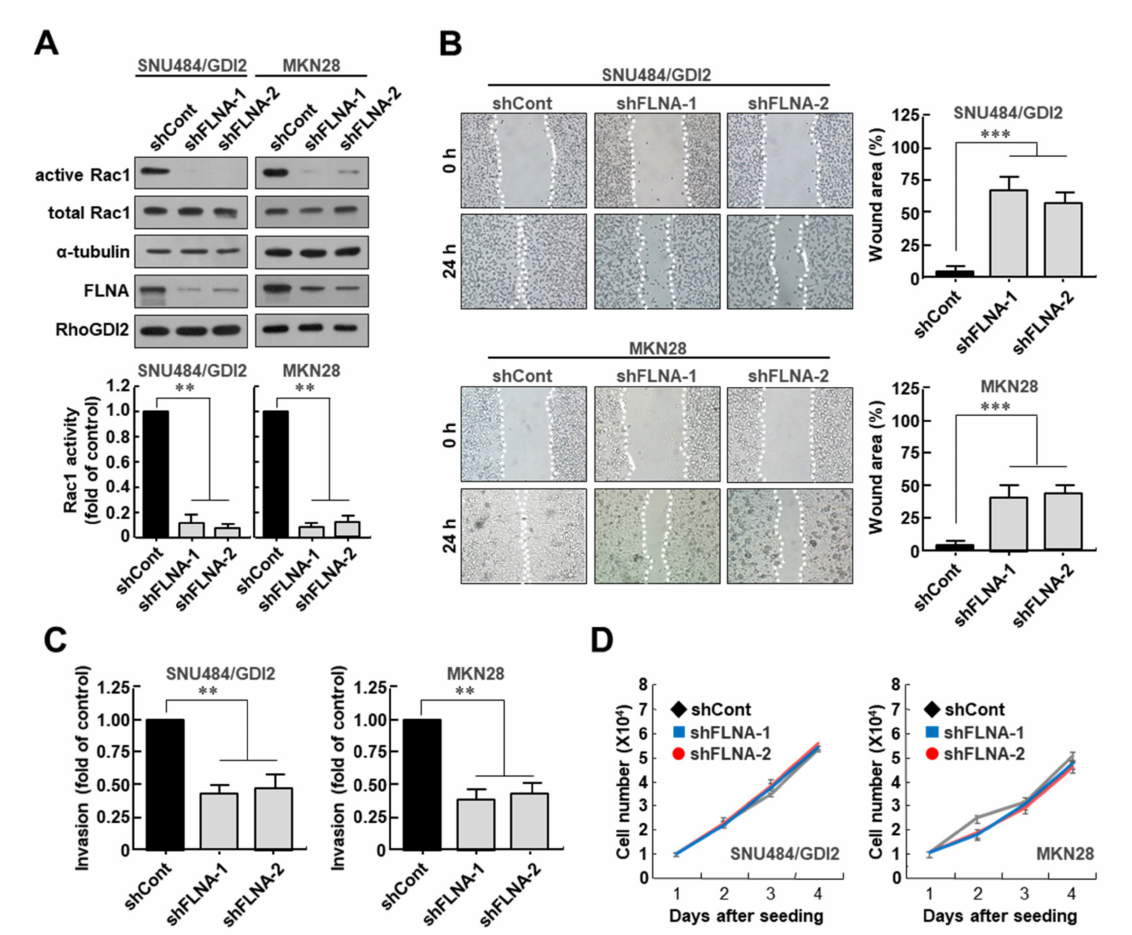
Figure 3. Filamin A is required for Rac1 activation and invasive ability of gastric cancer cells. ( A ) Effect of Filamin A depletion on Rac1 activity in RhoGDI2-overexpressing SNU484 and MKN28 gastric cancer cell lines. Filamin A-depleted cell lysates were precipitated with a PAK1-agarose and analyzed by Western blot using anti-Rac1 antibody (upper). The data are representative of three independent experiments and ImageJ software was used to calculate the relative active Rac1 levels (lower). For normalization, total Rac1 and α -tubulin expressions were used as controls. **, p < 0.01 as determined by t -test. The uncropped immunoblot images can be found in Figure S5. ( B ) Effect of Filamin A depletion on migration ability of RhoGDI2-overexpressing SNU484 and MKN28 gastric cancer cells. A wound-healing assay was used to examine the migration ability of Filamin A-depleted SNU484/GDI2 and MKN28 cells, with wound closure visualized using phase-contrast microscopy ( left ). WimScratch software (Wimasis) was used to measure the wound areas. The percentage of the wound area is expressed as the means ± SD of three separate experiments ( right ). ***, p < 0.001 as determined by t -test. ( C ) Effect of Filamin A depletion on invasive ability of RhoGDI2-overexpressing SNU484 and MKN28 gastric cancer cell lines. Filamin A-depleted SNU484/GDI2 and MKN28 cells were cultured onto matrix-coated upper chambers and the number of invading cells was measured after 24 h. The data are presented as the means ± SD of three separate experiments, carried out in triplicate. **, p < 0.01 as determined by t -test. ( D ) Effect of Filamin A depletion on proliferation rate of RhoGDI2-overexpressing SNU484 and MKN28 gastric cancer cell lines. The indicated cells were cultured at a concentration of 1 × 10 4 cells per well in a 6-well plate. After trypan blue staining, the viable cells were counted with a hemocytometer after 1 to 4 days of